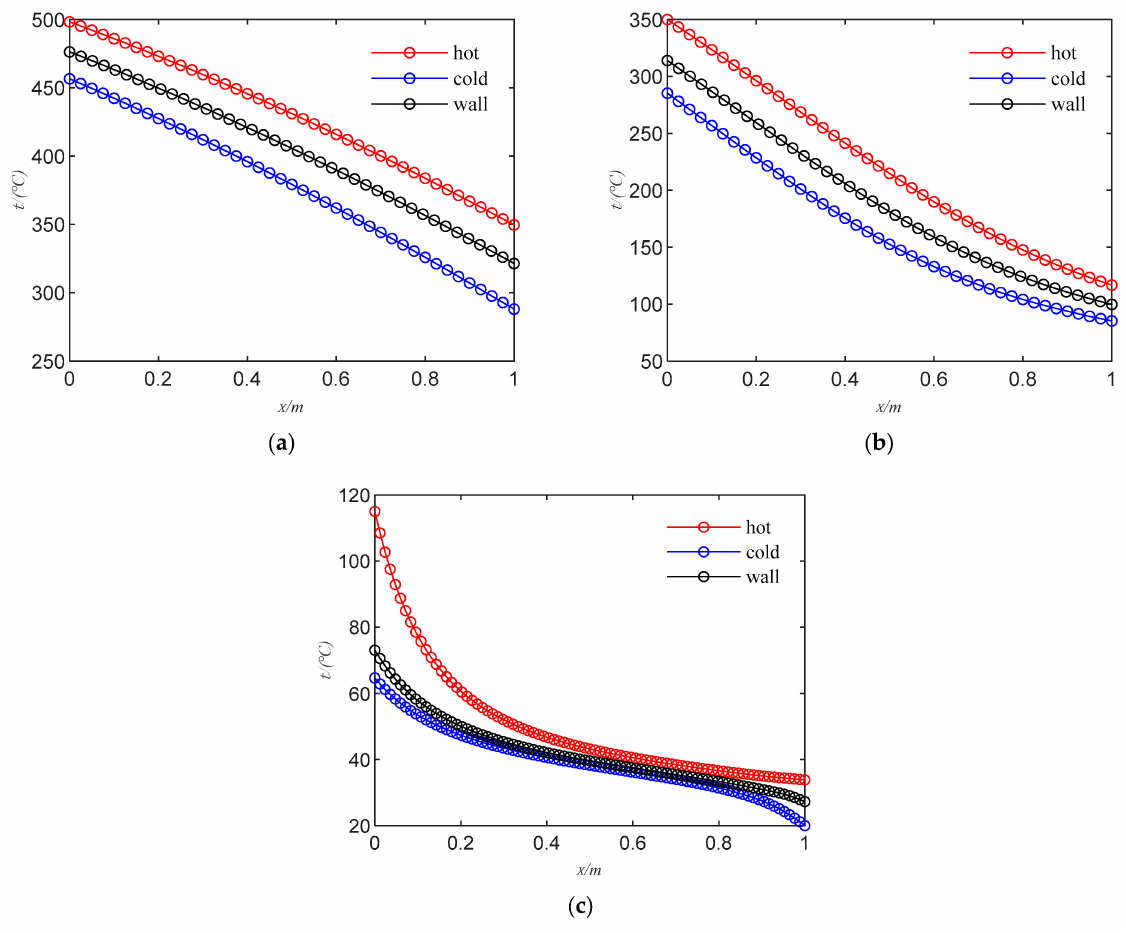
Figure 6. Steady-state temperature profile inside the heat exchanger under the designed condi- tions: ( a ) HTR (nearly linear distribution); ( b ) LTR (nonlinear distribution); ( c ) CL (strong nonlinear distribution).